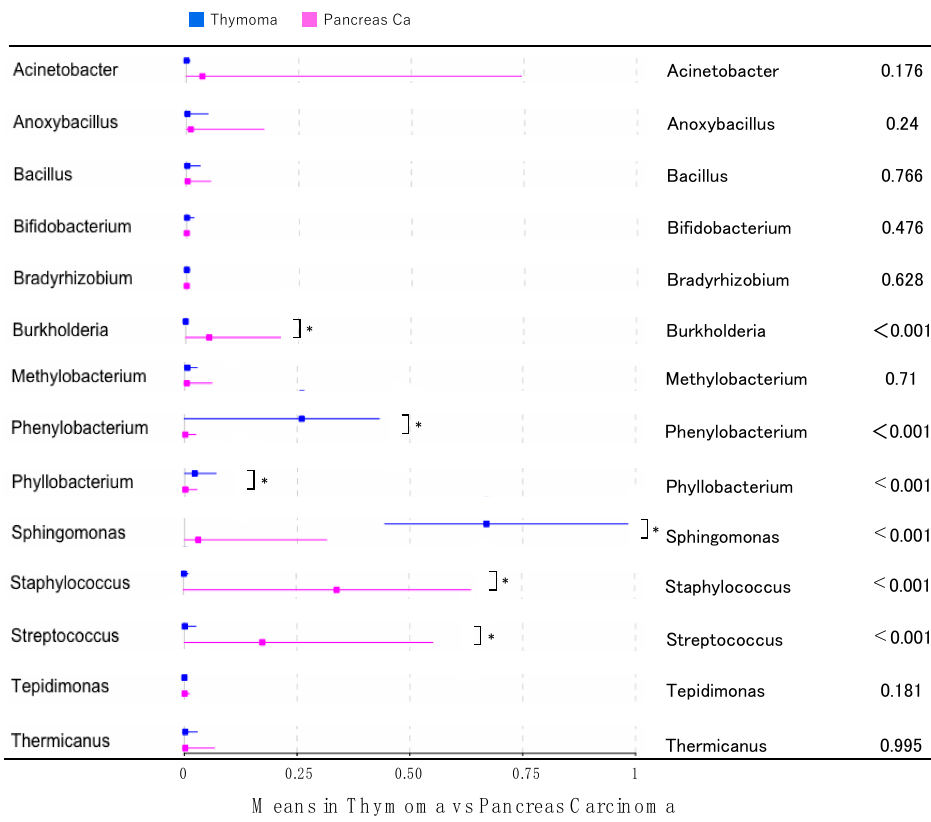
Figure 2. Microbiome differences between thymoma and pancreatic cancer samples. * p < 0.05.